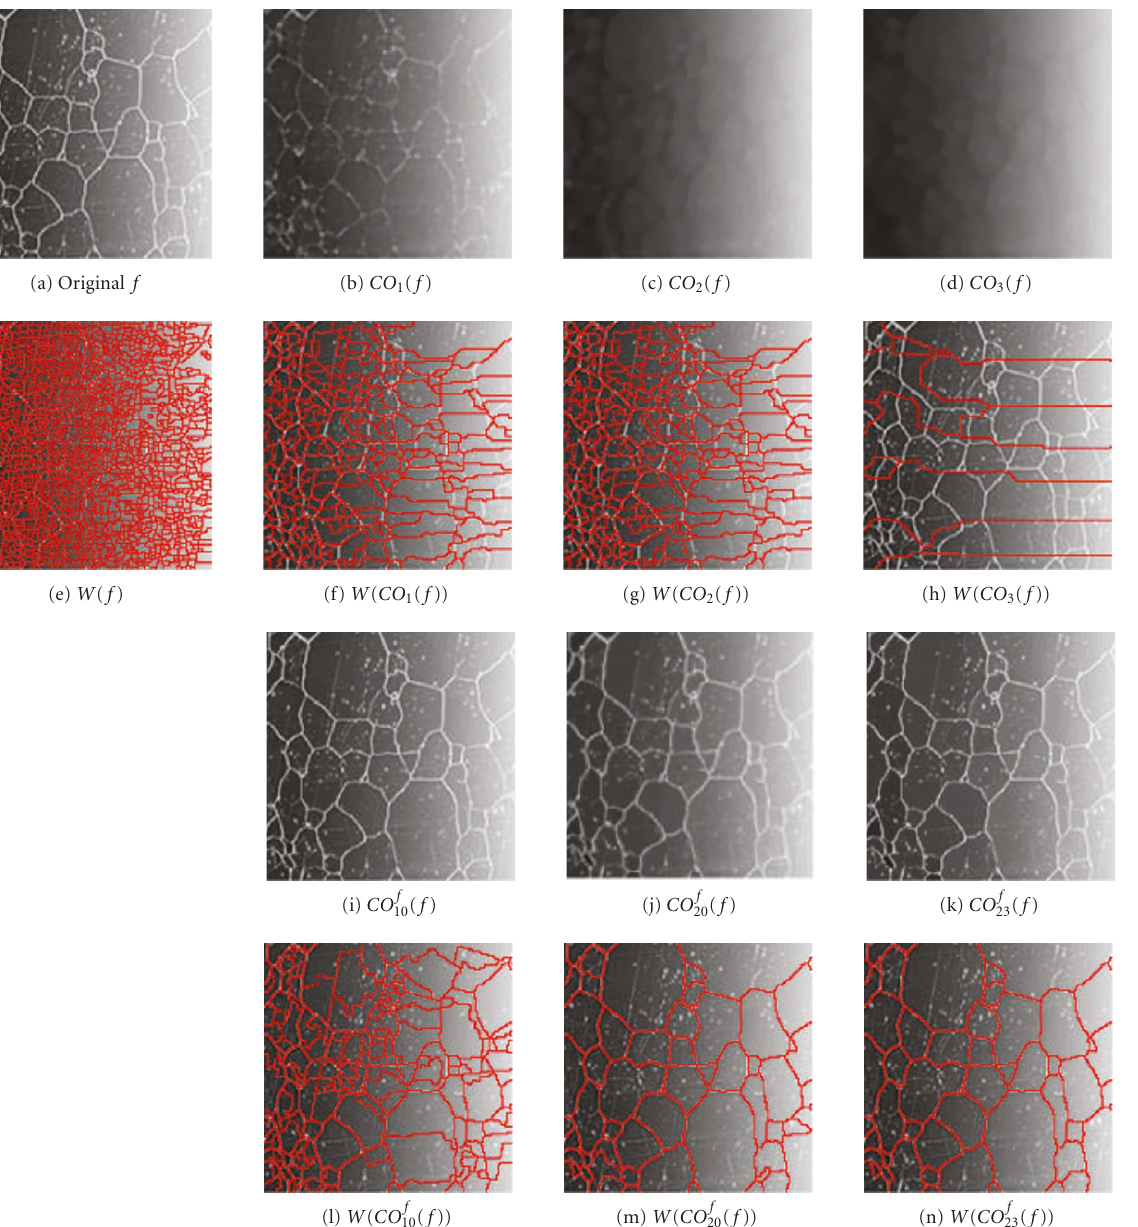
Figure 10: Segmentation of a real metallurgic grain boundaries (a) image. Pyramidal segmentation of the original (a) image. First, the origi- nal image is decomposed using classical (b)–(d) and adaptive LANIP-based (i)–(k) closing-openings. Second, the watershed transformation, denoted by W , is computed on the decomposed images, achieving the images (f)–(h) and (l)–(n), for the nonadaptive and LANIP approach, respectively. The original image is decomposed so as to avoid an over-segmentation (e). The adaptive approach provides a well-accepted = segmentation reached for the homogeneity tolerance m (cid:0)